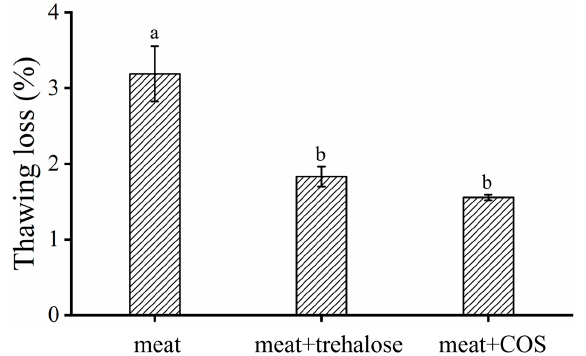
Figure 5. The effect of trehalose/COS on thawing loss of frozen meat. The results are mean ± stand- ard deviation, and the letters (a–c) in the same column indicate significant differences ( p < 0.05) between the data of different samples.